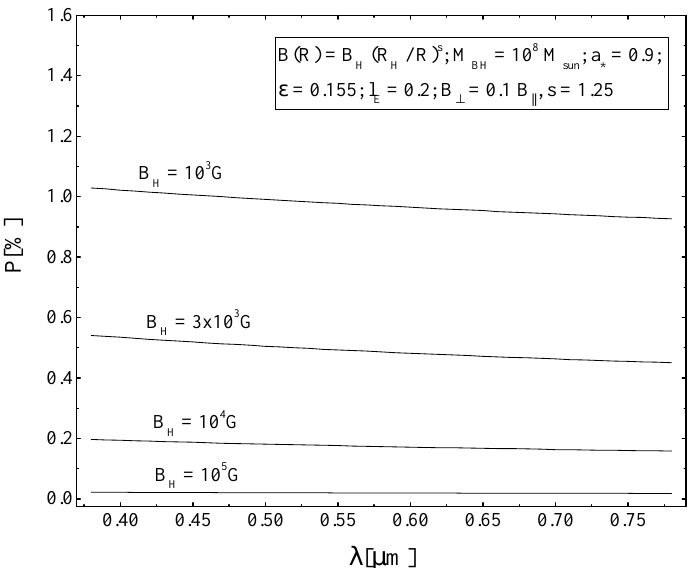
Figure 5. Dependence of the degree of polarization P on the wavelength λ for different values of the parameter B H .